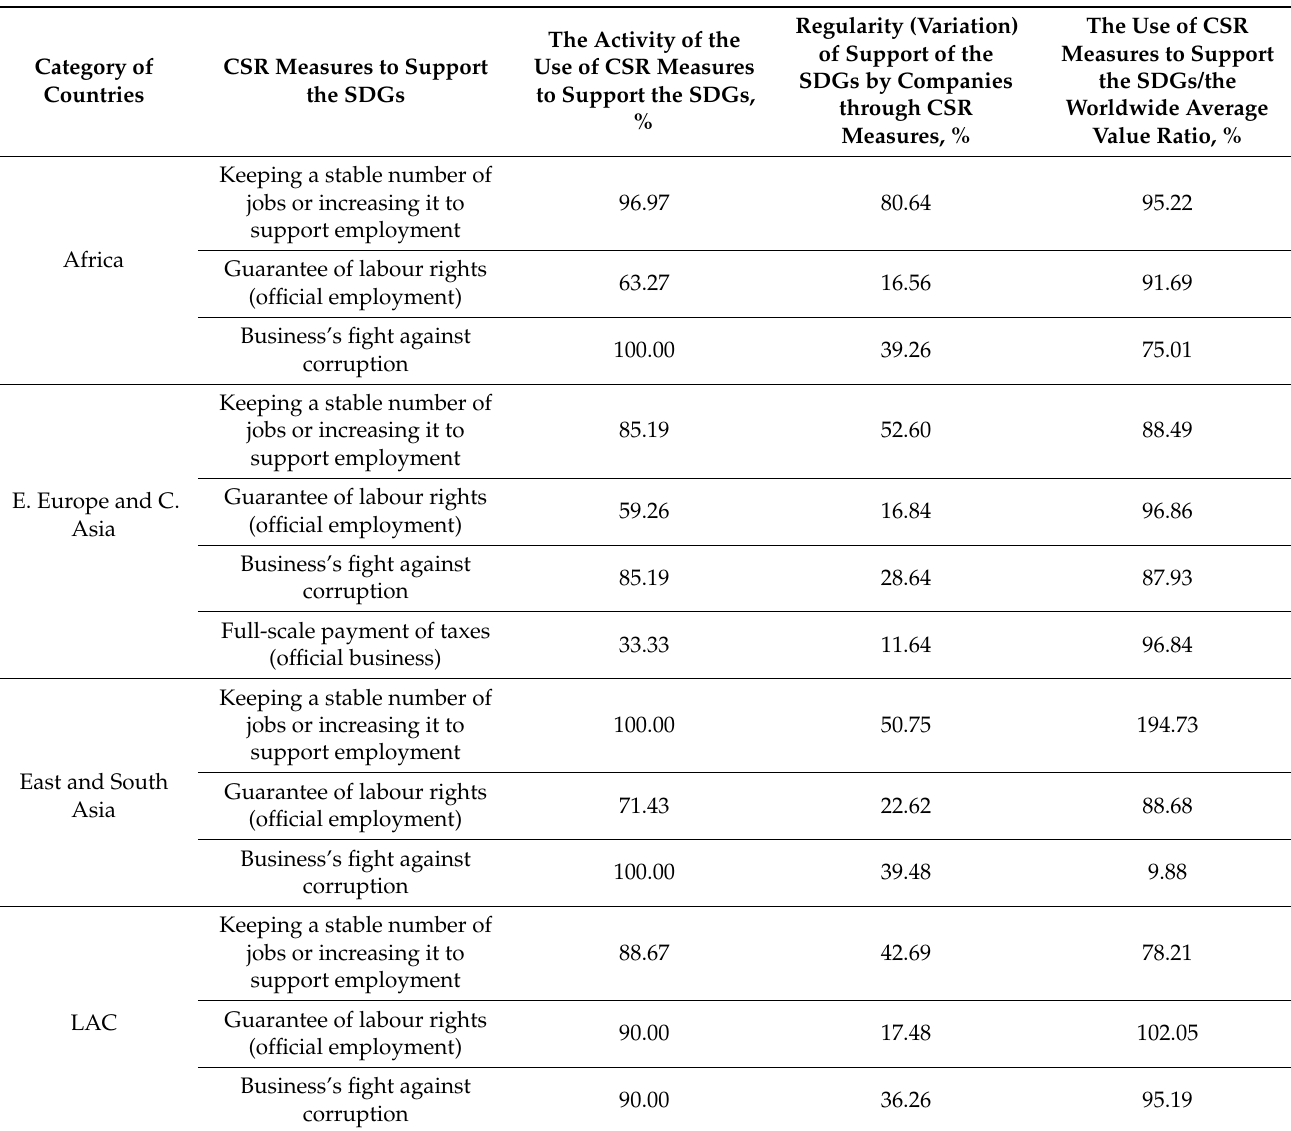
Table 12. Specific CSR measures to support the SDGs and the scale of their implementation in regions of the